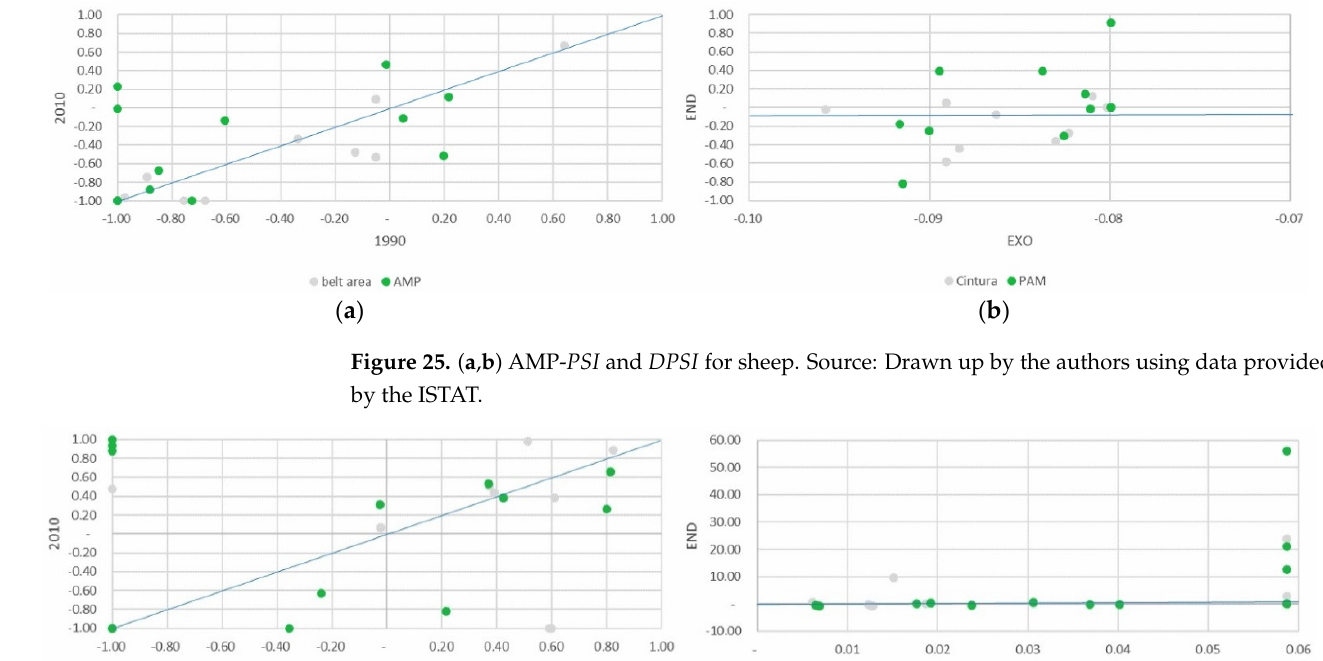
Figure 26. ( a , b ) AMP- PSI and DPSI for horses. Source: Drawn up by the authors using data provided